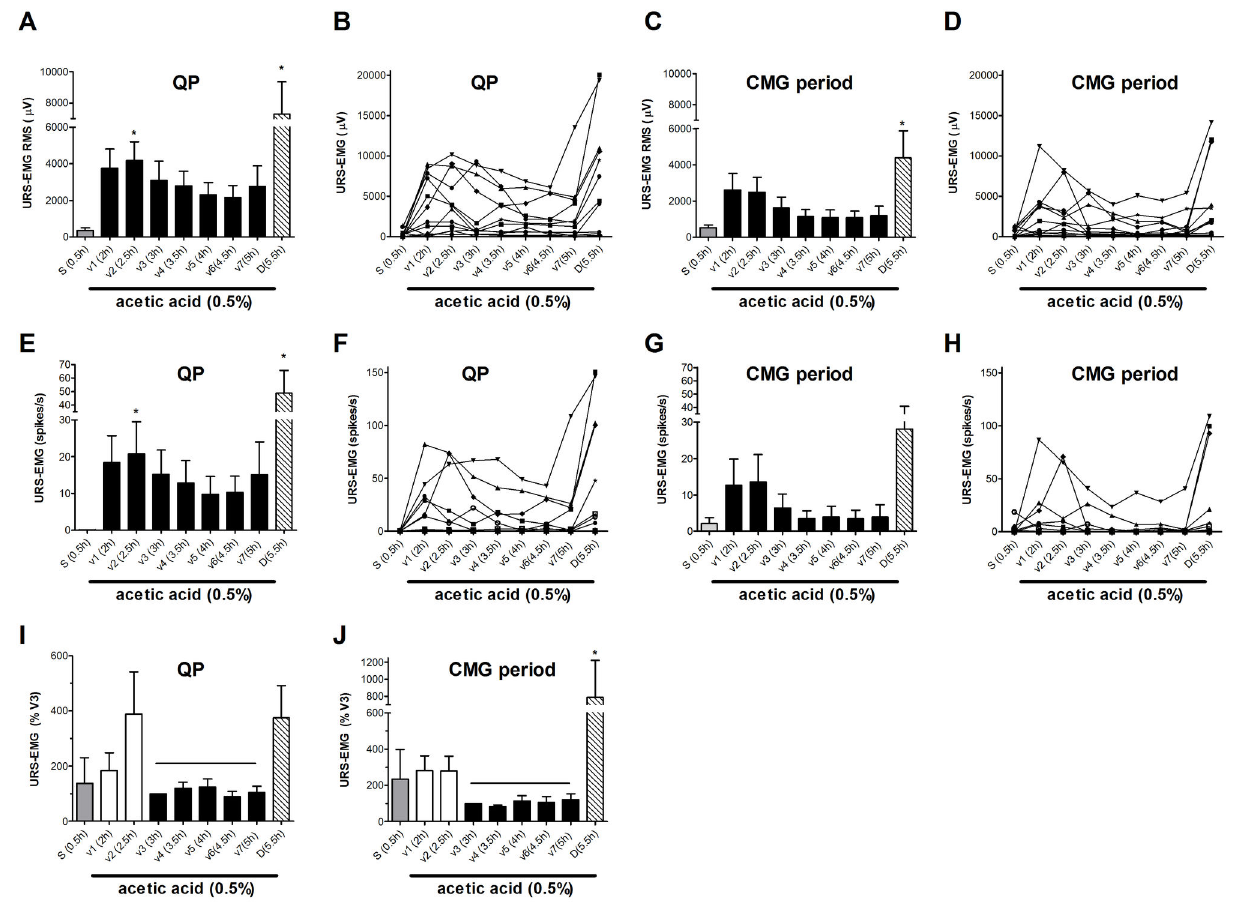
Figure 4. Summary of URS-EMG parameters. A–D. URS-EMG expressed as RMS during QP (A, B) and CMG periods (C, D). A, C show averaged data from 12 cats and B, D show data from individual cats. E–H. URS-EMG expressed as spikes/s during QP (E,F) and CMG periods (G,H). E, G show averaged data from 12 cats and F, H show data from individual